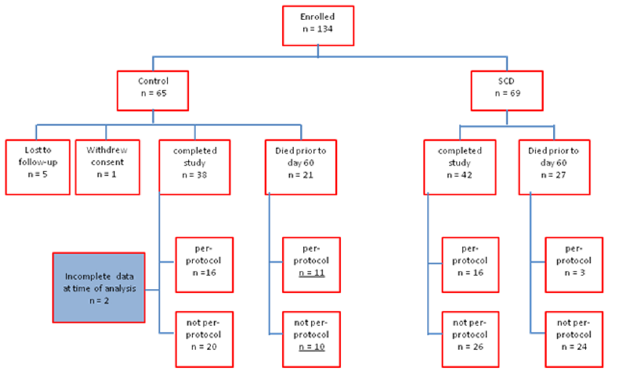
Fig 1. Flow chart of the disposition in all of the patients (N = 134) enrolled. For the purpose of statistical analysis ITT is defined as all control and all treatment, whereas mITT is defined as all control and all treatment with iCa at recommended range > 90% of the